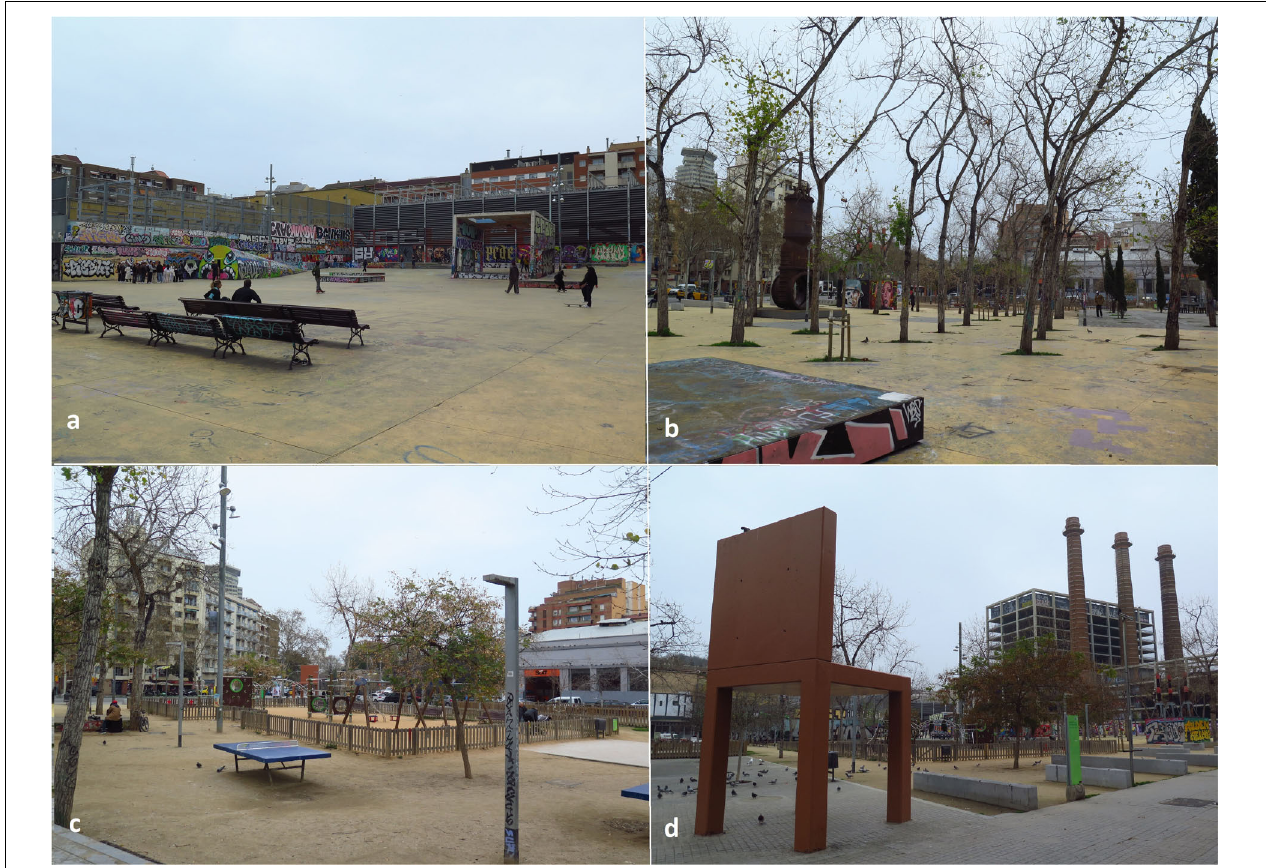
FIGURE 2 | Three Chimneys Park, (a) The esplanade; (b) Passage area characterized by trees and parts of the old machinery used as sculptures; (c) Playground area, ping-pong tables, and resting zone with benches; and (d) Panoramic view of the iconic three chimneys that give the park its name. Source: Authors.